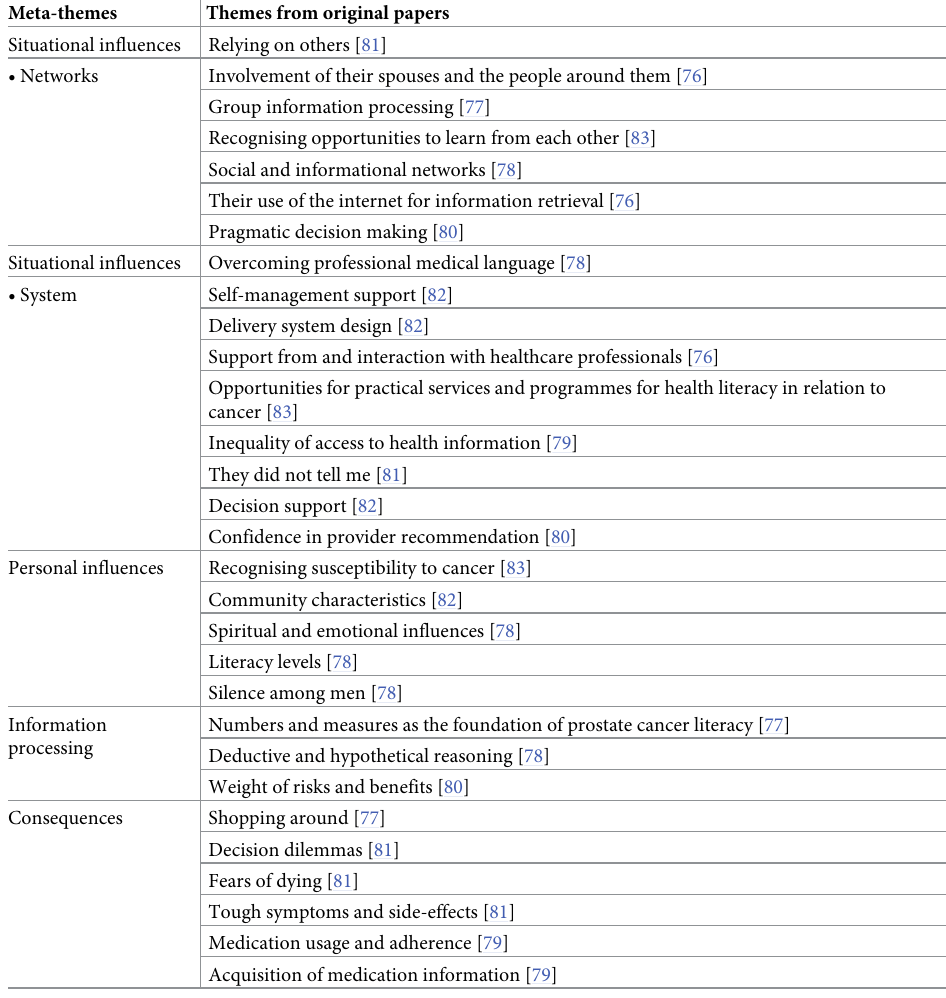
Table 4. Meta-themes and the contributory themes extracted from original